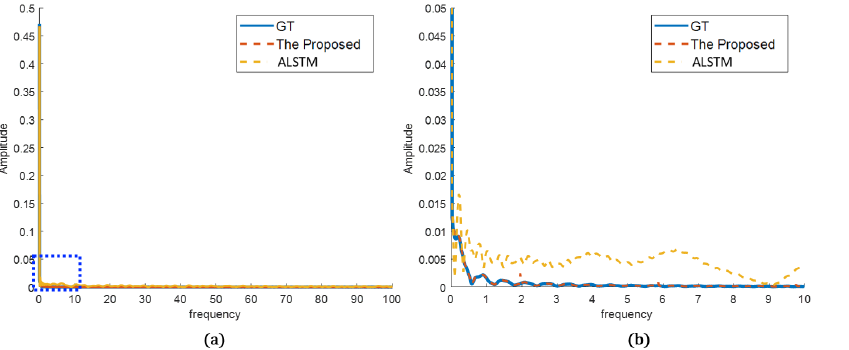
Figure 14. Prediction results in frequency domain (sensor B): ( a ) overview of the proposed and the best of the other methods compared to the GT; ( b ) detailed view of the blue dotted rectangle of ( a